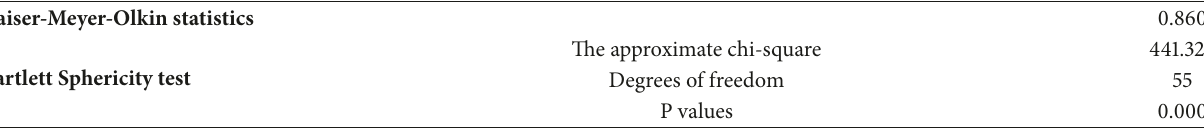
Table 3: KMO statistics and Bartlett test.